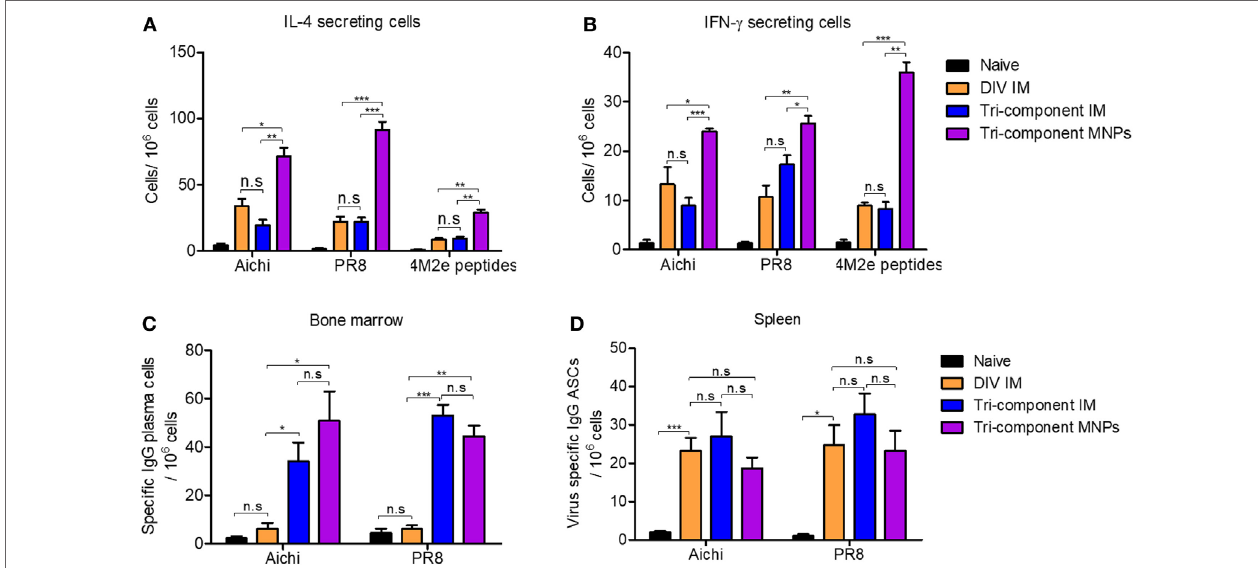
FigUre 2 | Cellular immune response after the immunization. Splenocytes and bone marrow cells were isolated from mice ( N = 4) at week 4 post vaccination. (a) IL-4-secreting cells in spleens and (B) IFN- γ -secreting cells in spleens. Cytokine-secreting cells in splenocytes were measured in the presence of 4 µg/ml purified inactivated Aichi virus, PR8 virus, or M2e peptides as stimulators by the ELISPOT method. (c,D) Numbers of Aichi- and PR8-specific IgG plasma cells in bone marrow and spleens, respectively. Data represent mean ± SEM. The statistical significance was analyzed by Student’s t -test. * p < 0.05, ** p < 0.01, *** p < 0.001, n.s p >